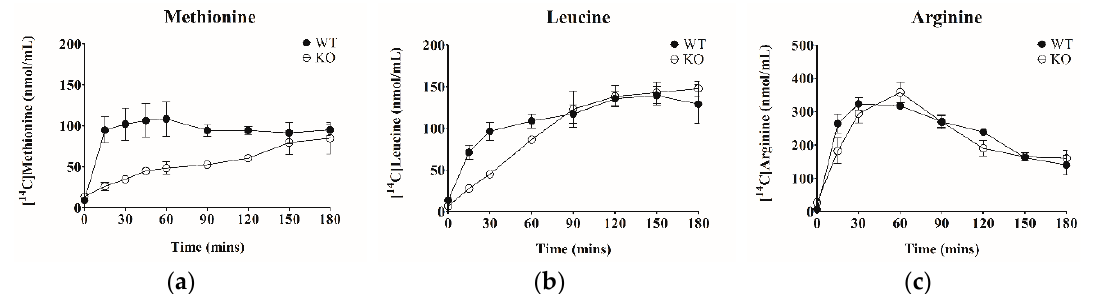
Figure 1. Absorption of amino acids in mouse intestine. Mixtures of unlabelled amino acids and specific radiolabelled amino acids were offered to mice as jelly food. Plasma concentration–time profiles of [14C]-methionine ( a ), [14C]-leucine ( b ) and [14C]-arginine ( c ) in SLC6A19ko ( ○ ) and SLC6A19wt ( ● ) mice. Data are expressed as mean ± S.E. ( n = 4). We hypothesized that reduced intestinal amino acid absorption in SLC6A19ko mice resulted in